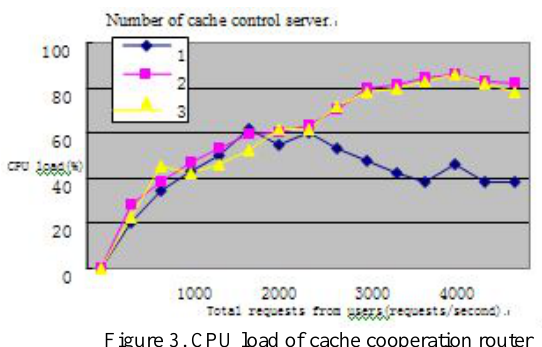
Figure 2. CPU load of cache control server